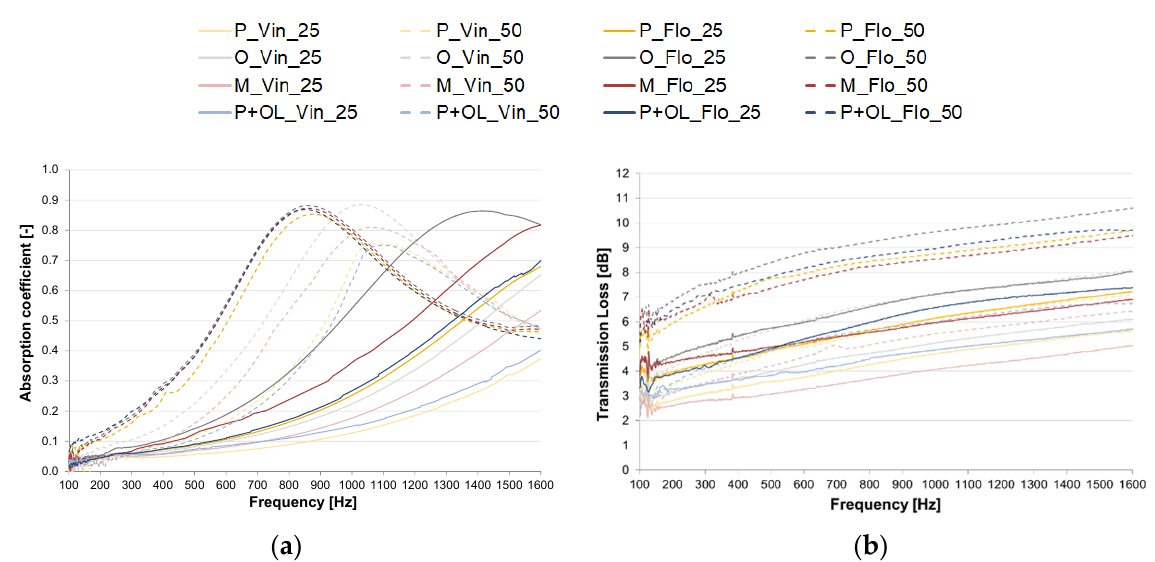
Figure 5. Acoustic properties of hand-assembled panels: ( a ) sound absorption coefficient and ( b ) Transmission loss at normal incidence.